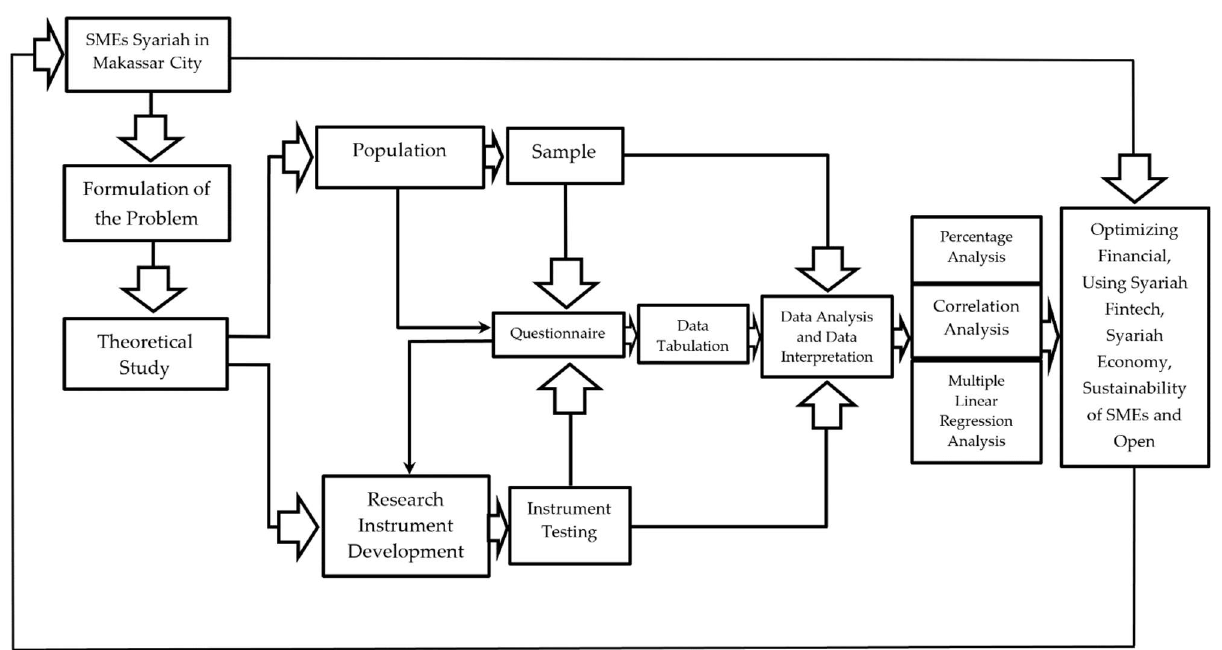
Figure 2. Research approach using quantitative methods. Source: Authors’ elaboration.